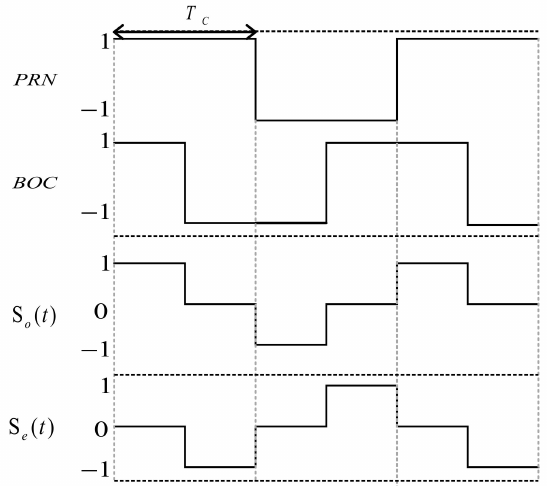
Figure 5. Local reference signal